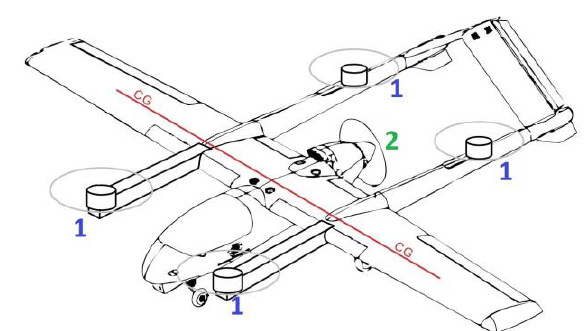
Figure 1. Sketch of a hybrid fixed-wing UAV with four vertical lift motors (1) and one pusher motor (2) for forward flight. The centre of gravity is illustrated in red (CG) (adapted from RMRC,